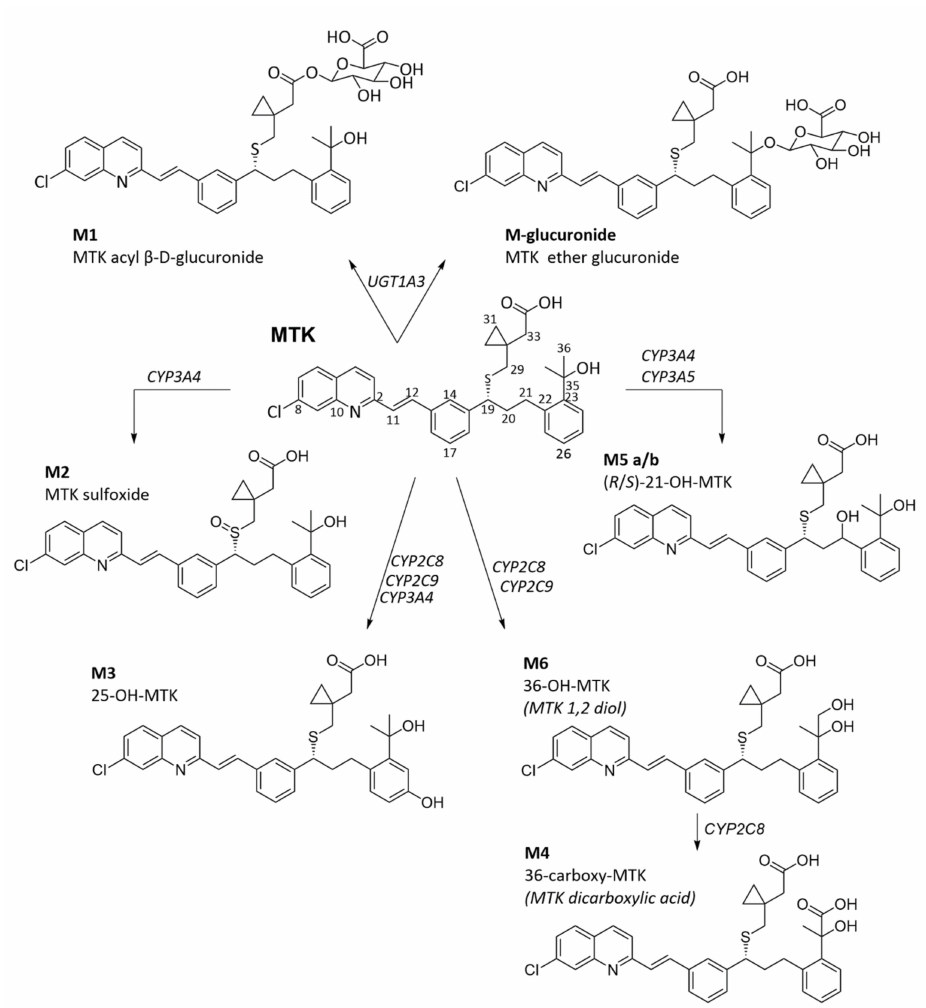
Figure 5. Human MTK metabolic pathways. The presented metabolites were identified in bile (M1, M- glucuronide, M2, M3, M4, and M6) and in plasma (M5 and M6) from healthy volunteers [120–123,125]. Atom numbering used in this work is included, in agreement with the literature numbering system used for